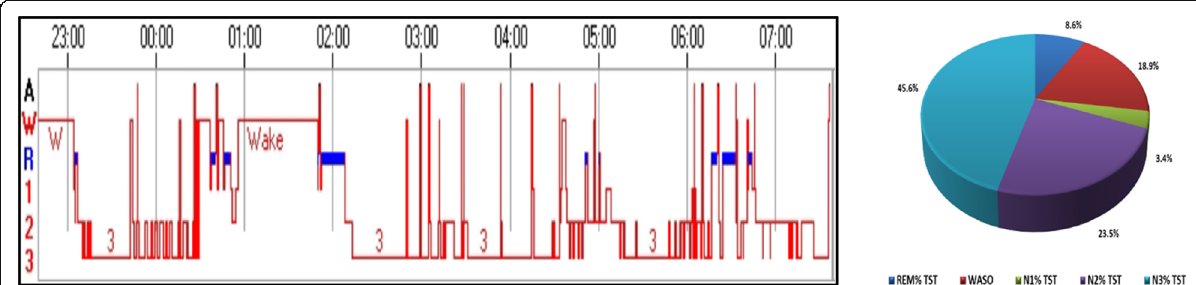
Fig. 2 Shortening of REM % TST and increased sleep fragmentation and waking after sleep